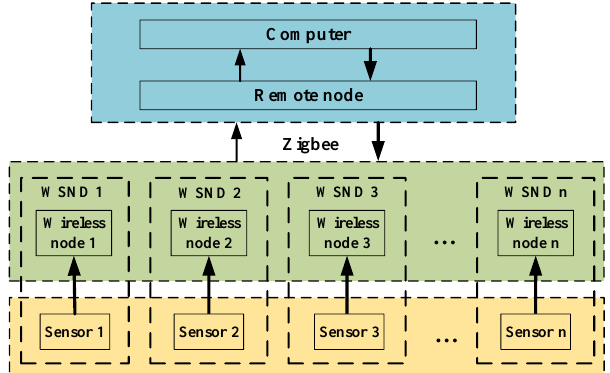
Figure 1. Structure of the wireless electric-field measurement system.